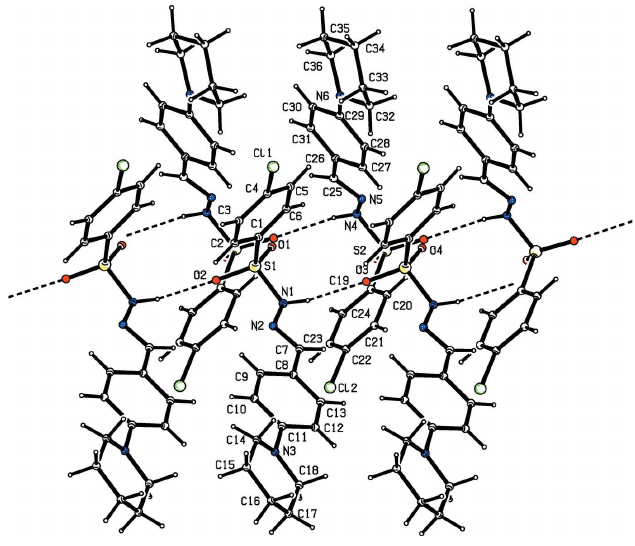
Figure 6 Hydrogen-bonding pattern in (III) with hydrogen bonds shown as dashed lines.